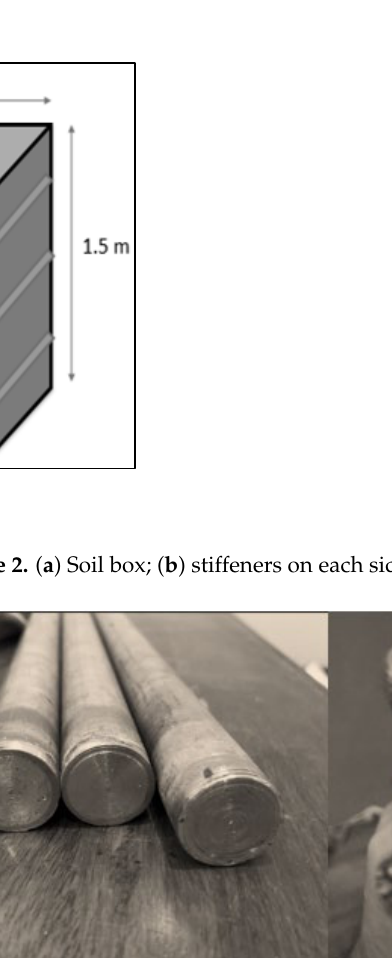
Figure 3. Galvanized iron pipes used as a pile in model piled raft.